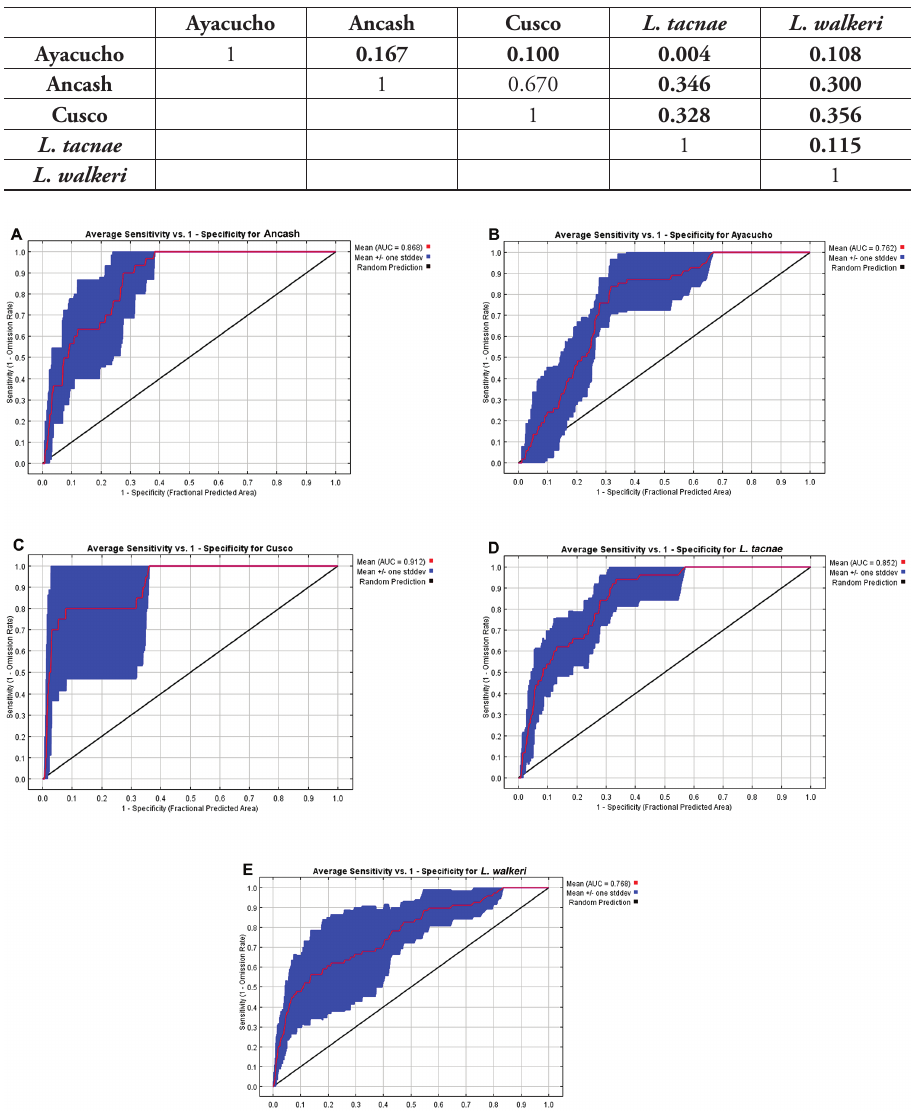
table 6. Schoener’s D values and Niche Identity test results between focal populations and species. A value in bold denotes a pair of species that has statistically distinct ENMs.